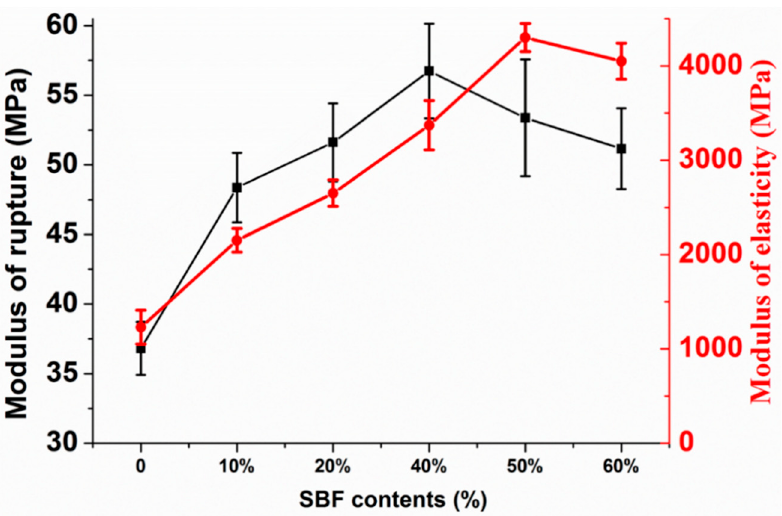
Figure 6. The modulus of rupture (MOR) and modulus of elasticity (MOE) of the pure PP and composites with different SBF contents.